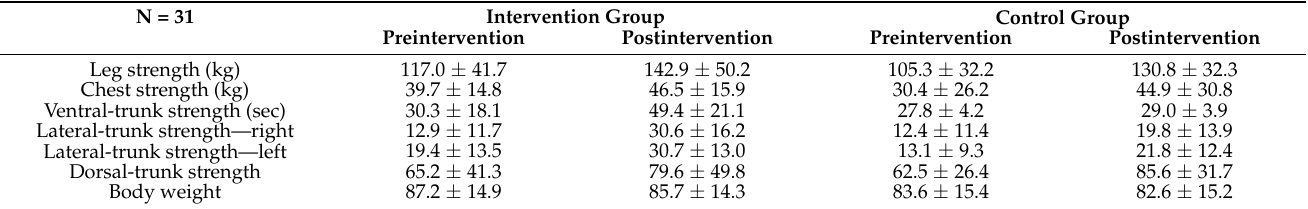
Table 6. Changes in the strength and body weight of control and intervention groups with the mean and standard deviation.